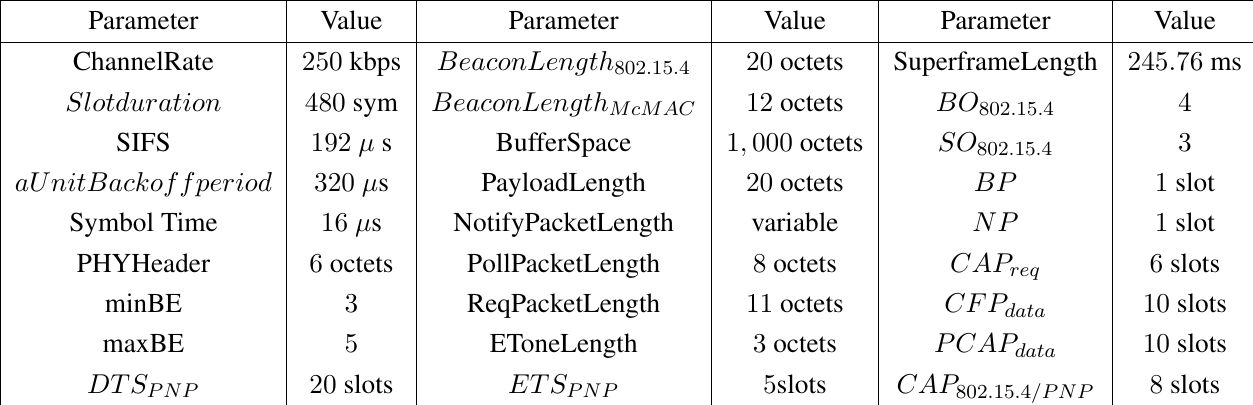
Table 3. Parameters and their values used in the